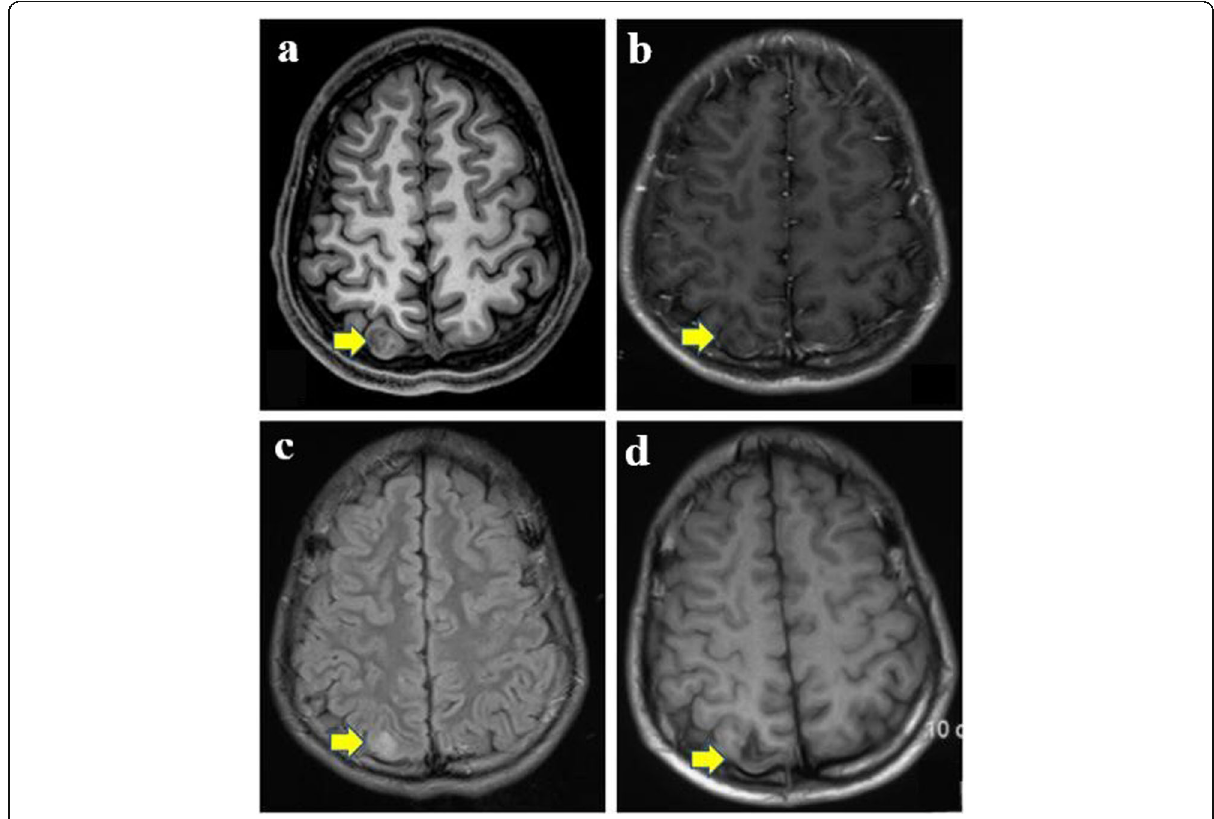
Fig. 1 Brain MRI. Yellow arrows indicate the lesion in the right parietal lobe. The lesion showed mixed signal with very clear boundary, without edema or signal enhancement. a T1-weighted image, b T1 enhancement, c T2 Flair image, d post-operative T1 weighted